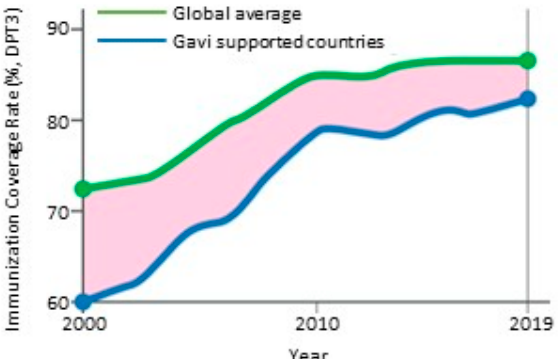
Figure 1. Contribution of Gavi in childhood immunization [36]. Coverage with third dose of diphtheria-pertussis-tetanus-containing vaccine. Source: WHO/UNICEF Estimates of National Immunization Coverage, 2020. Figure adapted from Gavi Annual Progress Report [36].